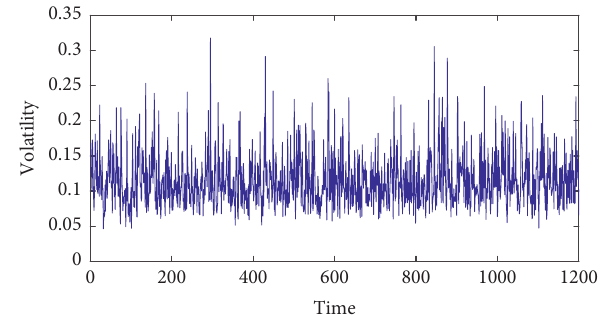
Figure 5: The simulated true volatility series.